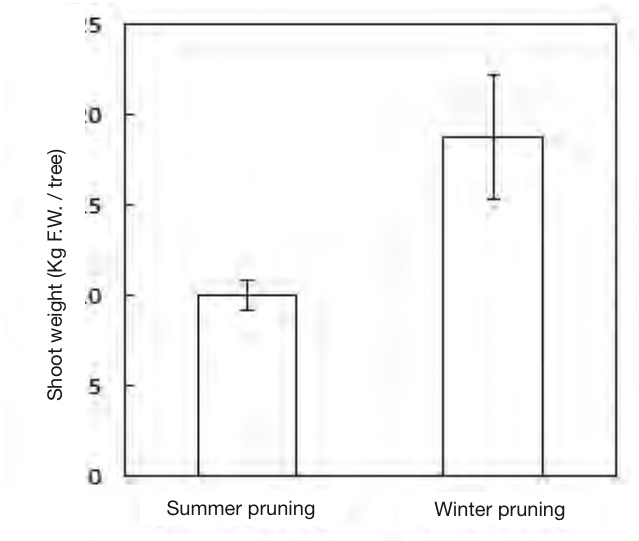
Fig. 2 - Weight of shoots removed by summer and winter pruning from peach trees. Data are presented as mean ± standard error ( se